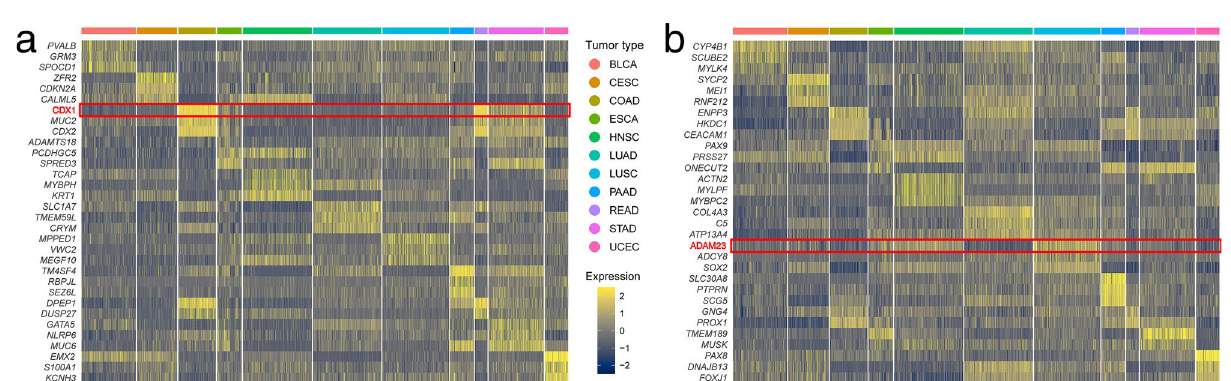
Figure 3. Top three the most specific genes per tumor. ( a ) AP-2α unique targets. ( b ) AP-2γ unique targets. In-text examples are marked with red. Figure created using Seurat 4.0.4 (https:// CRAN.R- proje ct. org/ packa ge=